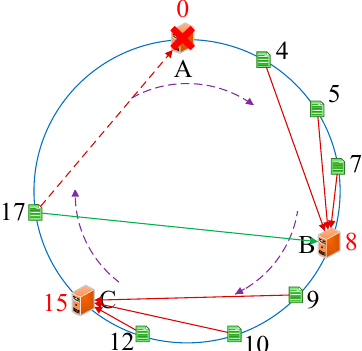
Figure 10. The changing of deploying locations of applications using the DCH-based algorithm.